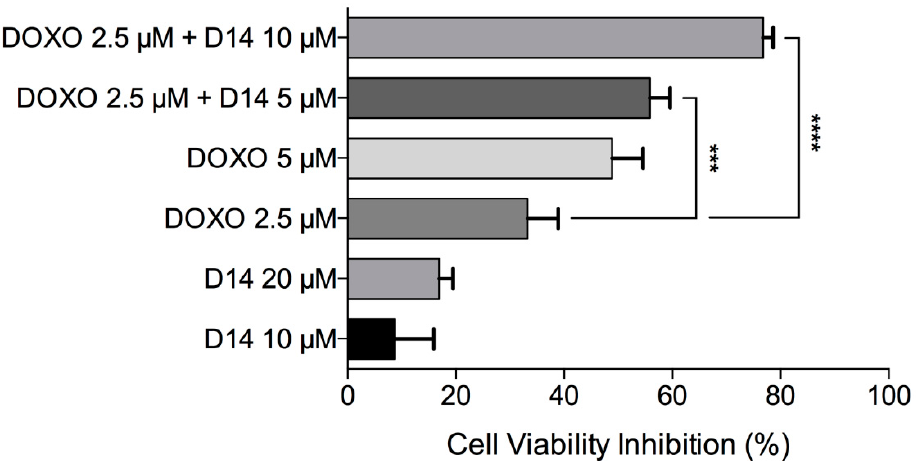
Figure A4. Deconvolution of the PVA majority peak into amorphous and crystallinity peaks in order to calculate the % crystallinity. Only two peaks were used for deconvolution in order to represent an average value of the whole hydrogel.